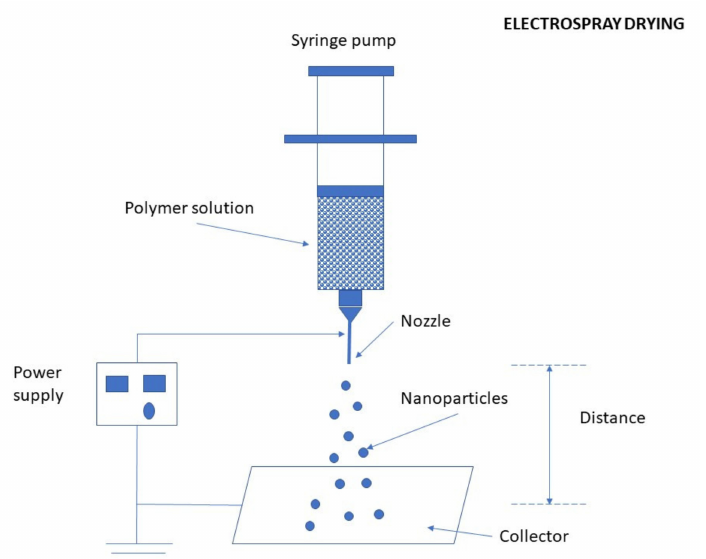
Figure 11. Preparation of CS NPs by the electrospraying